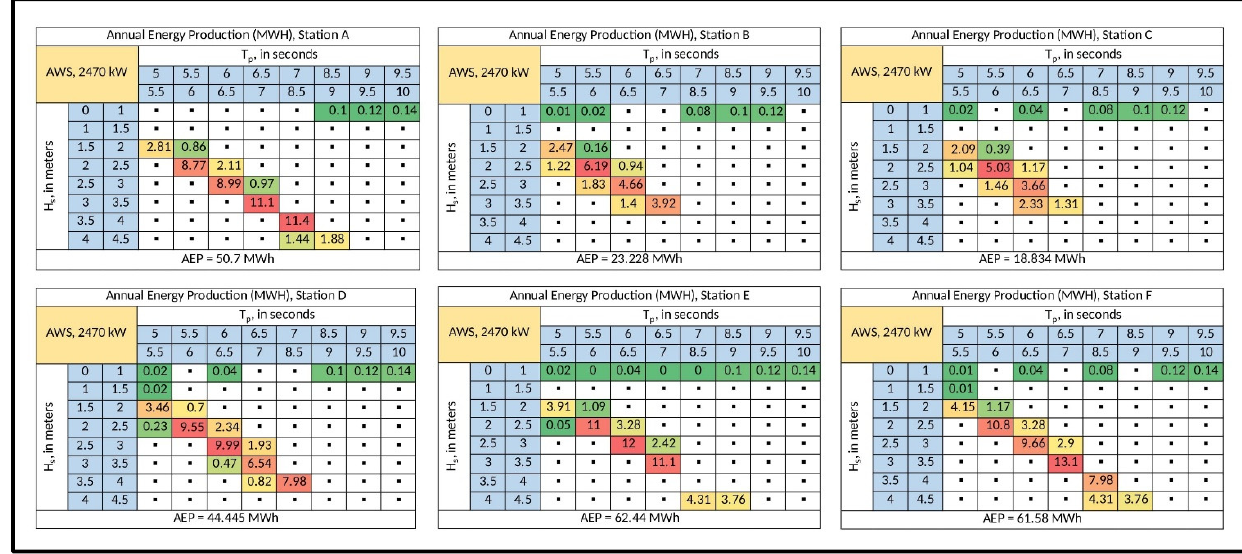
Figure A5. AEP computations of AWS at stations A–F.